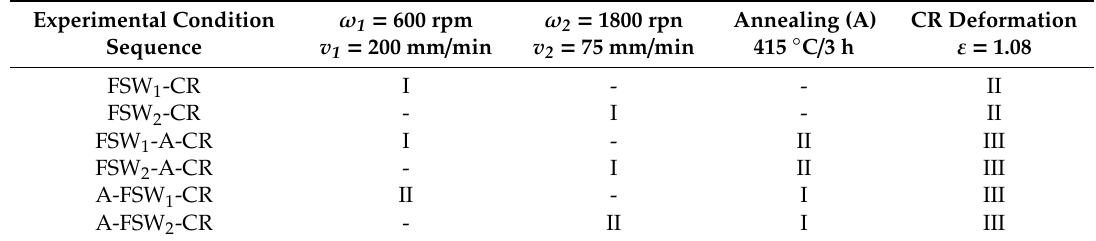
Table 1. Experimental conditions tested in the present study and the sequence of the three different treatments to which the AA5754 was subjected (from the first, I, the second, II, and to the third, III). Experimental Condition